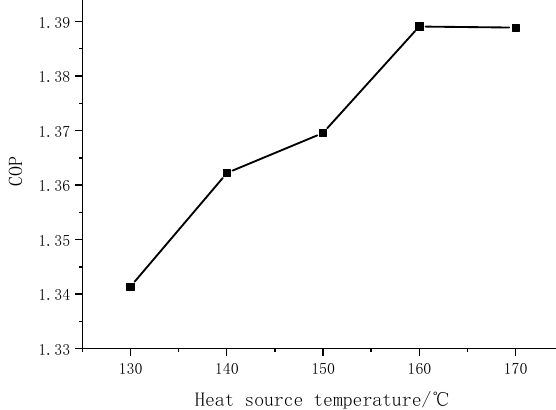
Figure 4. E ff ect of heat source temperature on system performance. Figure 4. Effect of heat source temperature on system performance.